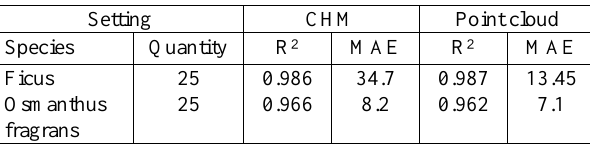
Table 2 . Extraction results of different tree